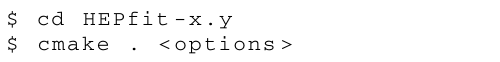
type II contours, the coloured dashed lines represent the correspond- ing type I fits. Right panel: Allowed regions in the heavy Higgs boson massesandtheirmassdifferencesplanesintheTHDMoftypeI(dashed lines) and type II (solid lines). The unitarity bounds to the green, red and blue regions are meant at a probability of 99.7%, and the orange and grey lines mark the 95.4% boundaries. More details can be found in